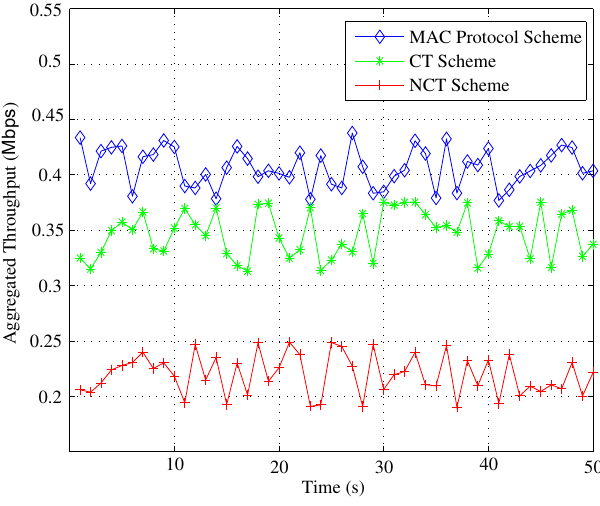
Fig. 6: Comparison of Different Schemes in Terms of Aggregated Throughput for Unoccupied Channels Equal to 2/3